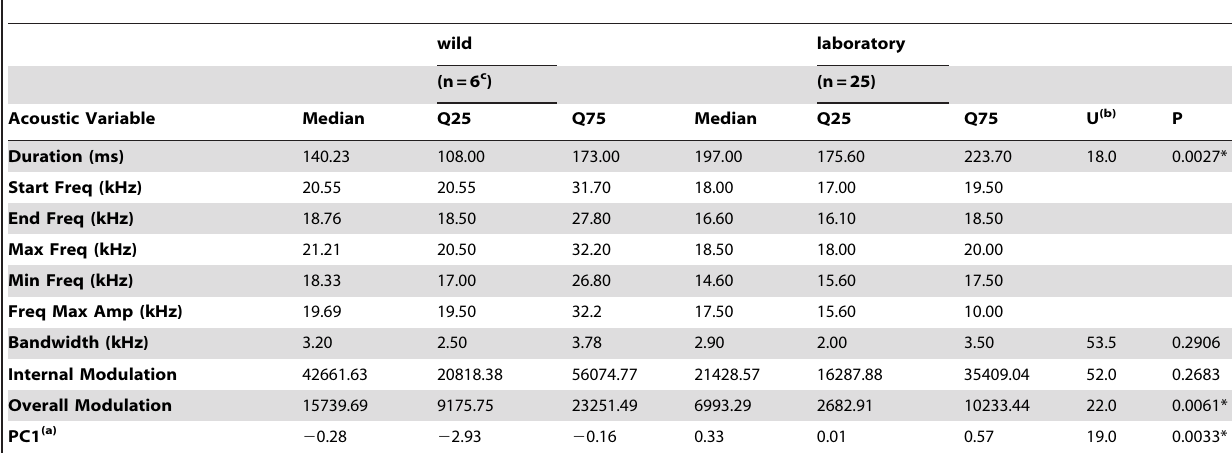
Table 1. Comparison between laboratory- and wild-recorded 1SVs with Mann-Whitney U statistics.